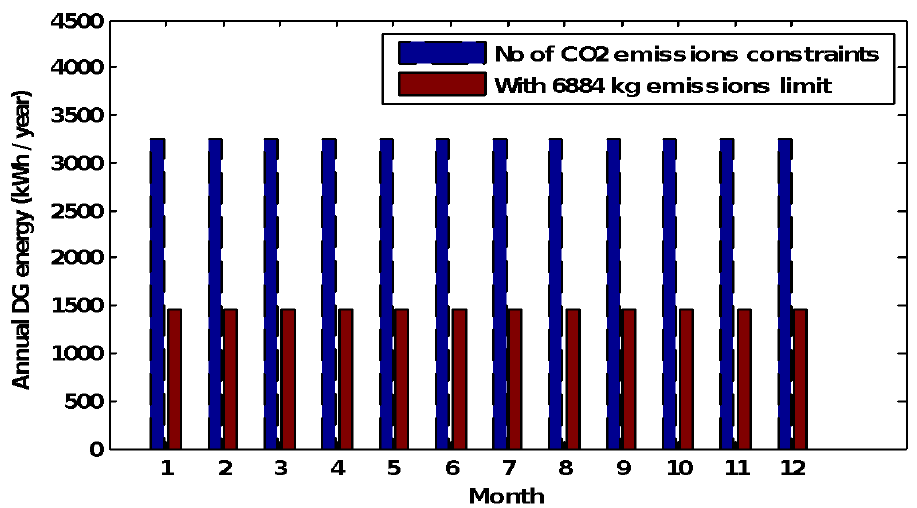
Figure 7. Monthly DG energy in a year with and without constraints using